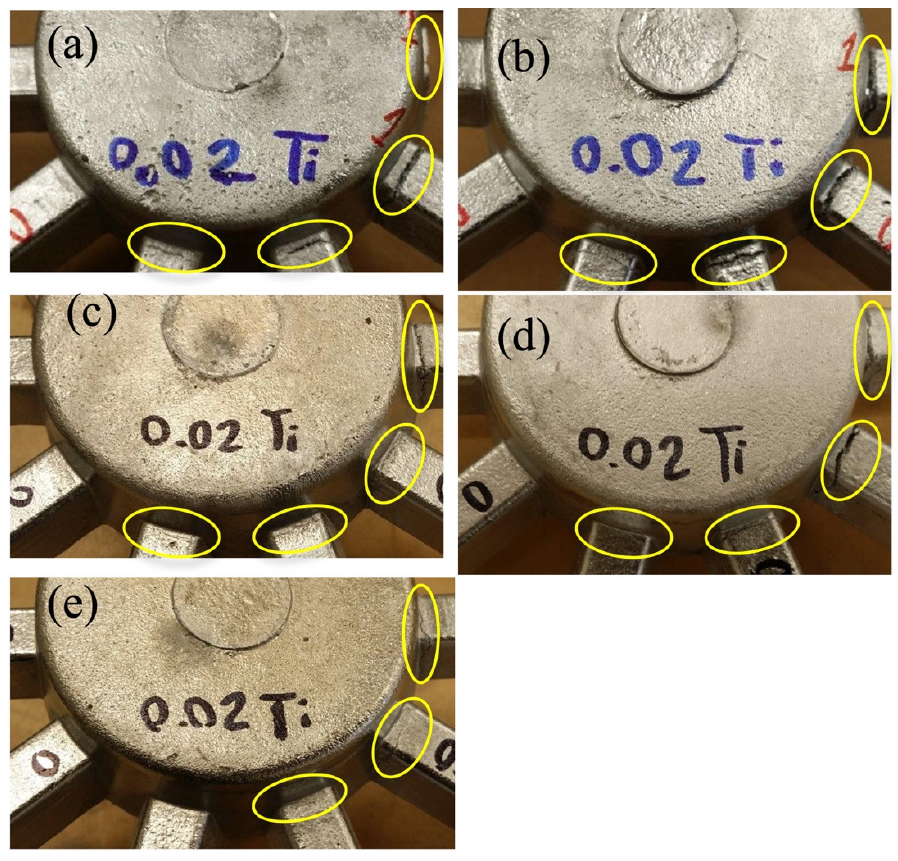
Figure 5. Pictures of representative multi-arm castings without grain refining: ( a ) DA1, ( b ) DA2, ( c ) DA5, ( d ) DA6, and ( e ) DA7.